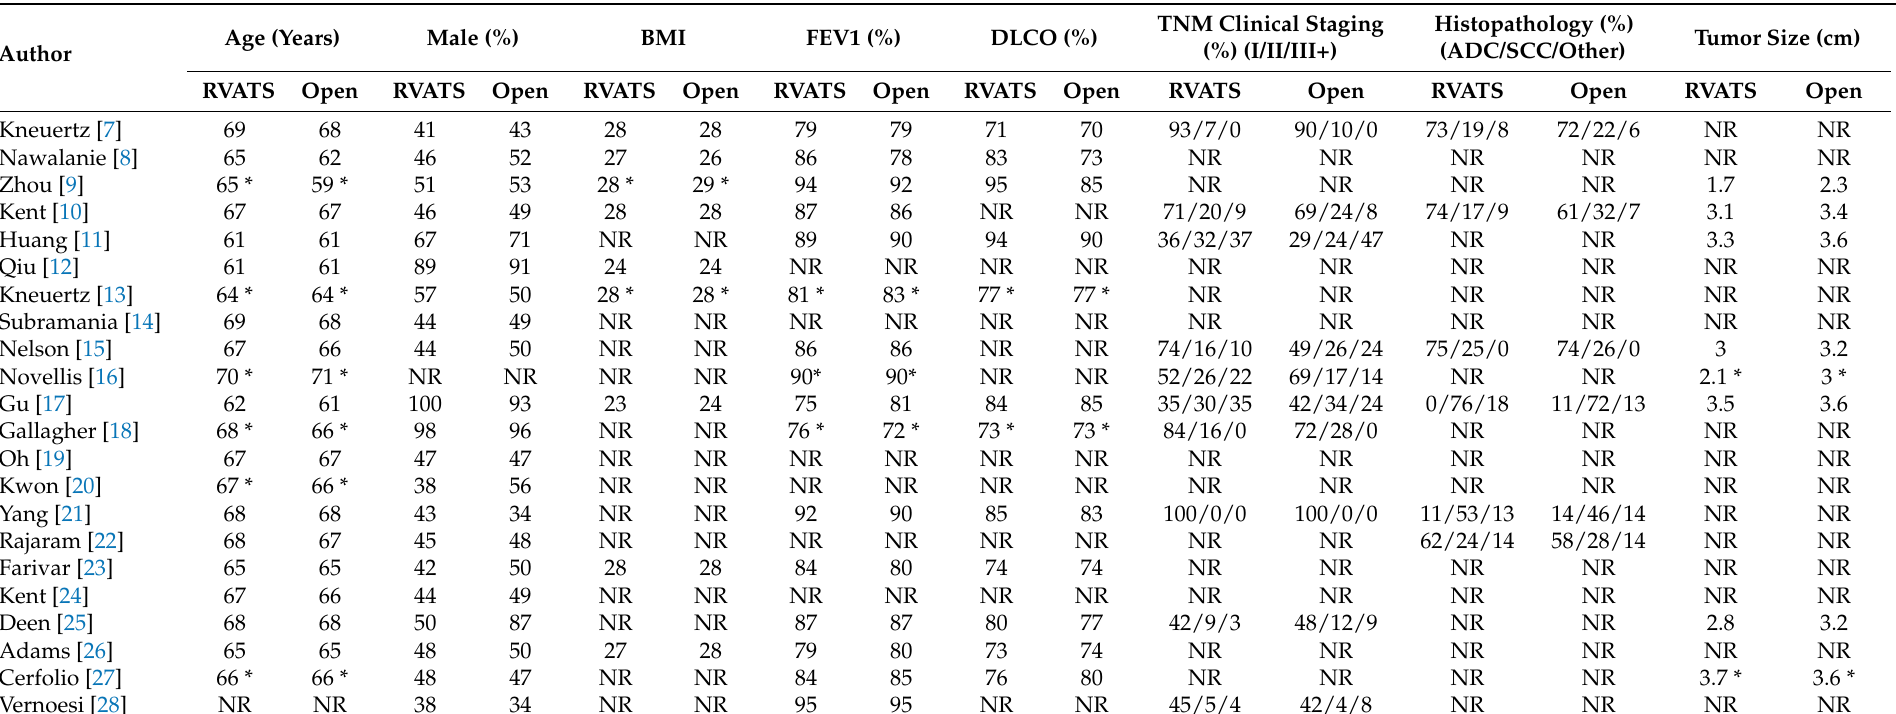
Table 2. Summary of baseline characteristics of patients who underwent robotic video-assisted thoracoscopic surgery compared with open thoracotomy for resectable non-small cell lung